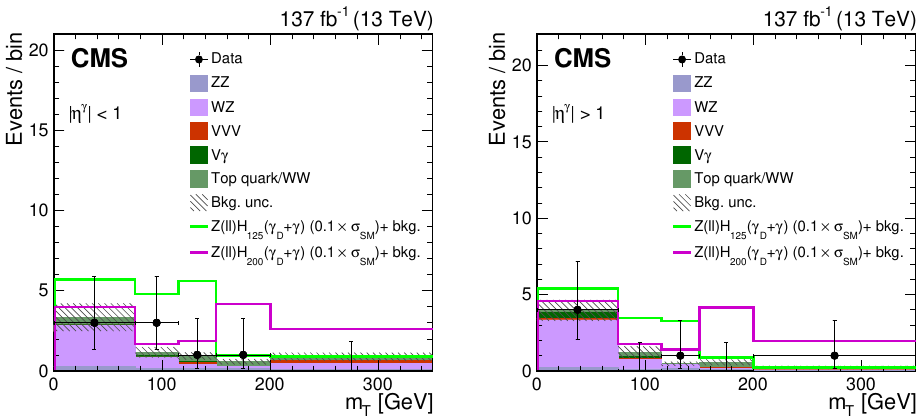
Figure 3 . The m distributions in the signal region for two m T (left) and j (cid:17) (cid:13) j > 1 (right), after the (cid:12)t to data. The signal size corresponds to 0 : 1 (cid:27) values of m shown. The signal processes are stacked on top of all backgrounds. Statistical and H systematic uncertainties in the expected background yields are represented by the hatched band. Vertical bars represent data statistical uncertainties, while horizontal bars represent the bin widths.